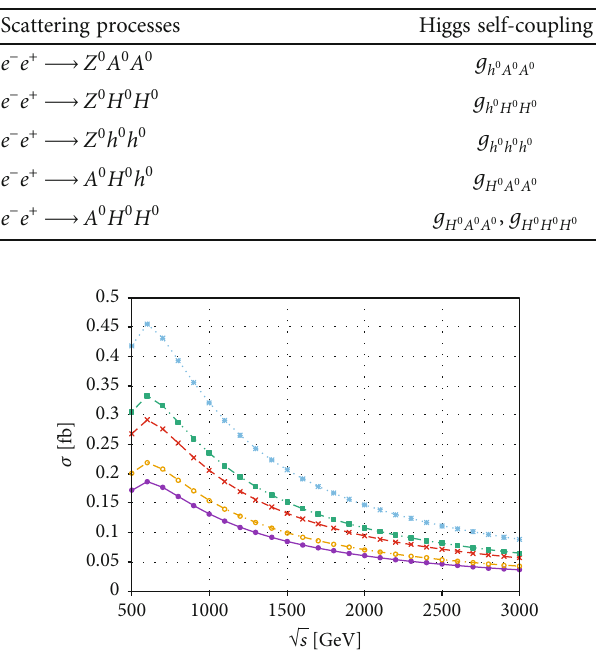
Figure 3: The left-most diagram contains the Higgs self-coupling vertex corresponding to the process e + e − ⟶ Zhh . Table 2: The triple Higgs self-coupling contributing to scattering process while using the exact alignment limit equal to one and extra Higgs masses to be equal.